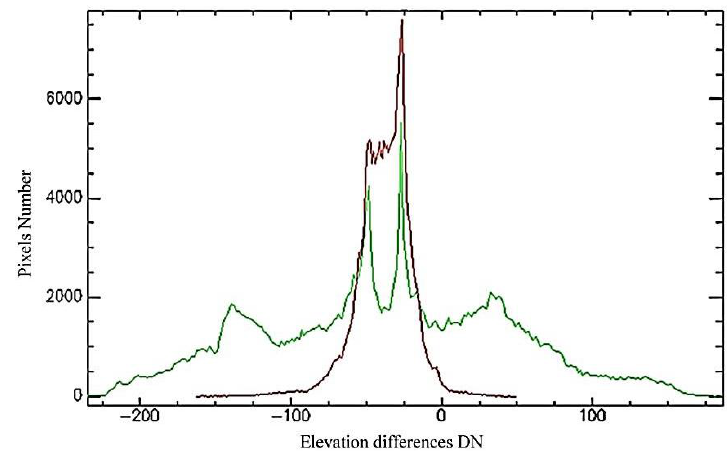
Figure 8. Histograms of the elevation difference data. Red for after co-registration and green for before